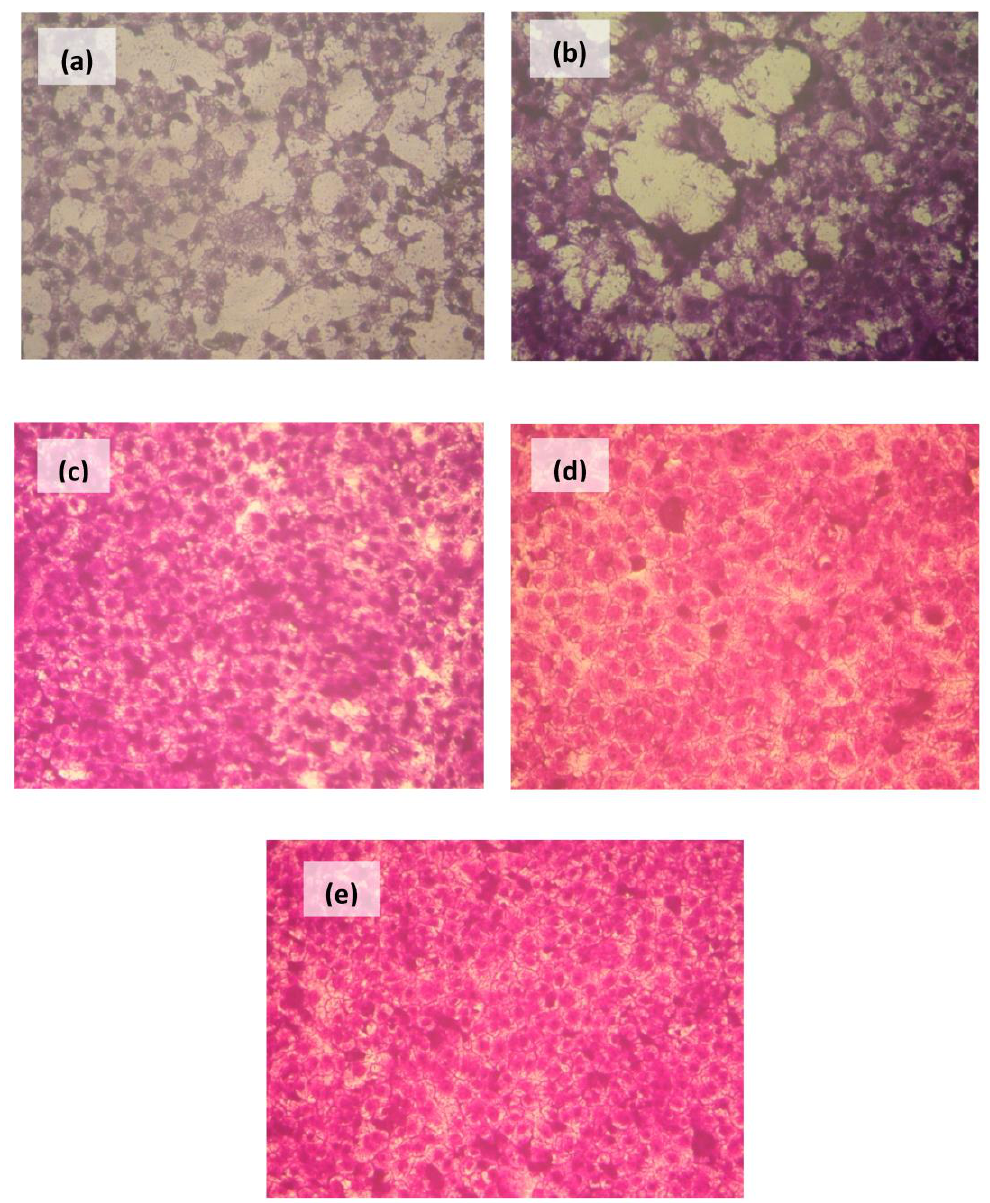
Figure 13. Microscopic examination of MRC-5 cells treated with 2Nph-BU-Cs/ZnONPs-5% at different concentrations: ( a ) 1000 µ g/mL, ( b ) 500 µ g/mL, ( c ) 250 µ g/mL, ( d ) 125 µ g/mL, compared with ( e ) non-treated MRC-5 cells (control). All the images were obtained at a magnification of 100×.